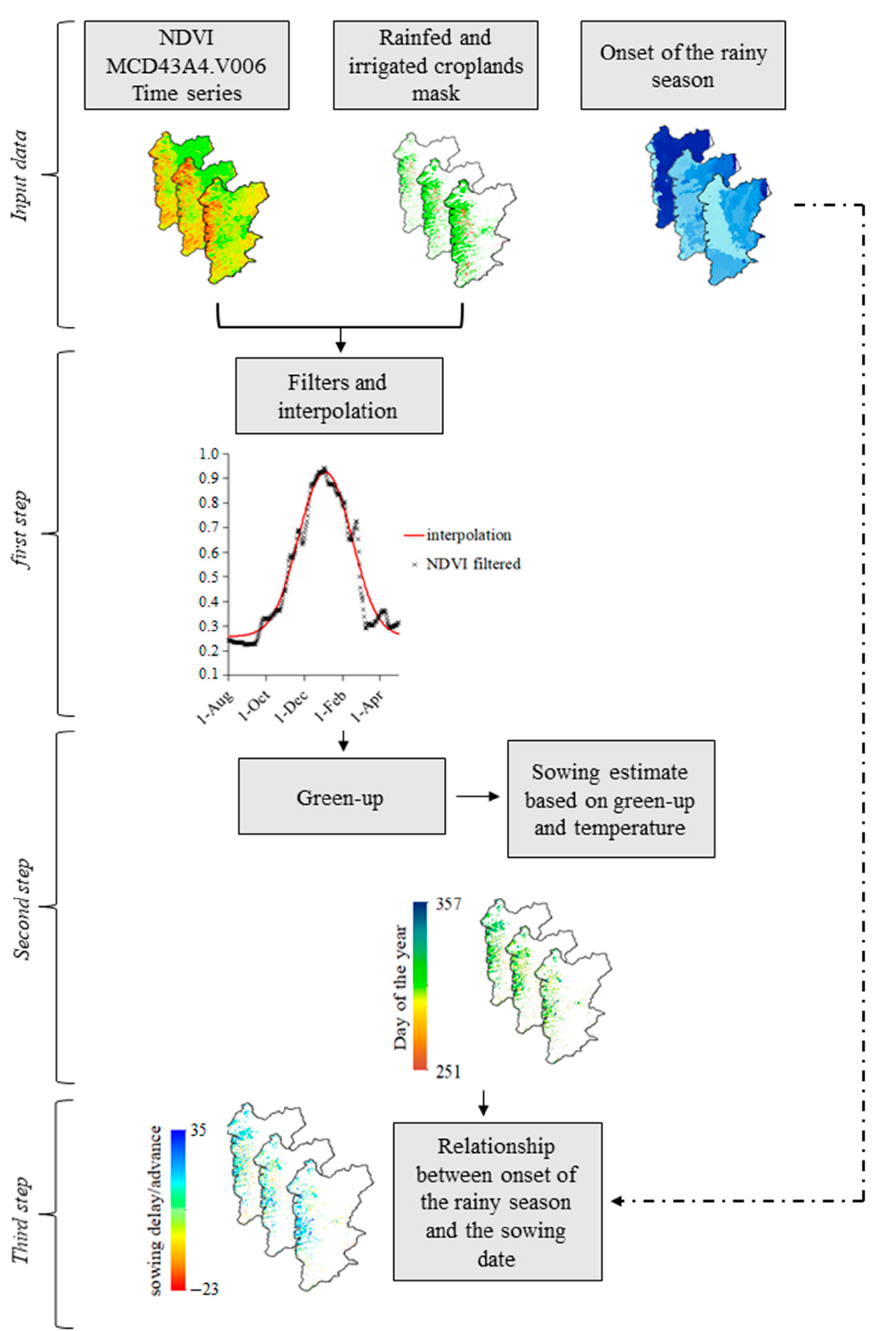
Figure 1. Steps for the determination of sowing and rainy season onset dates in Western Bahia.